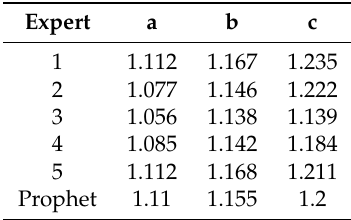
Figure 3. Round 2 of the fuzzy Delphi method. Table 1. Round 1 of the fuzzy Delphi method.